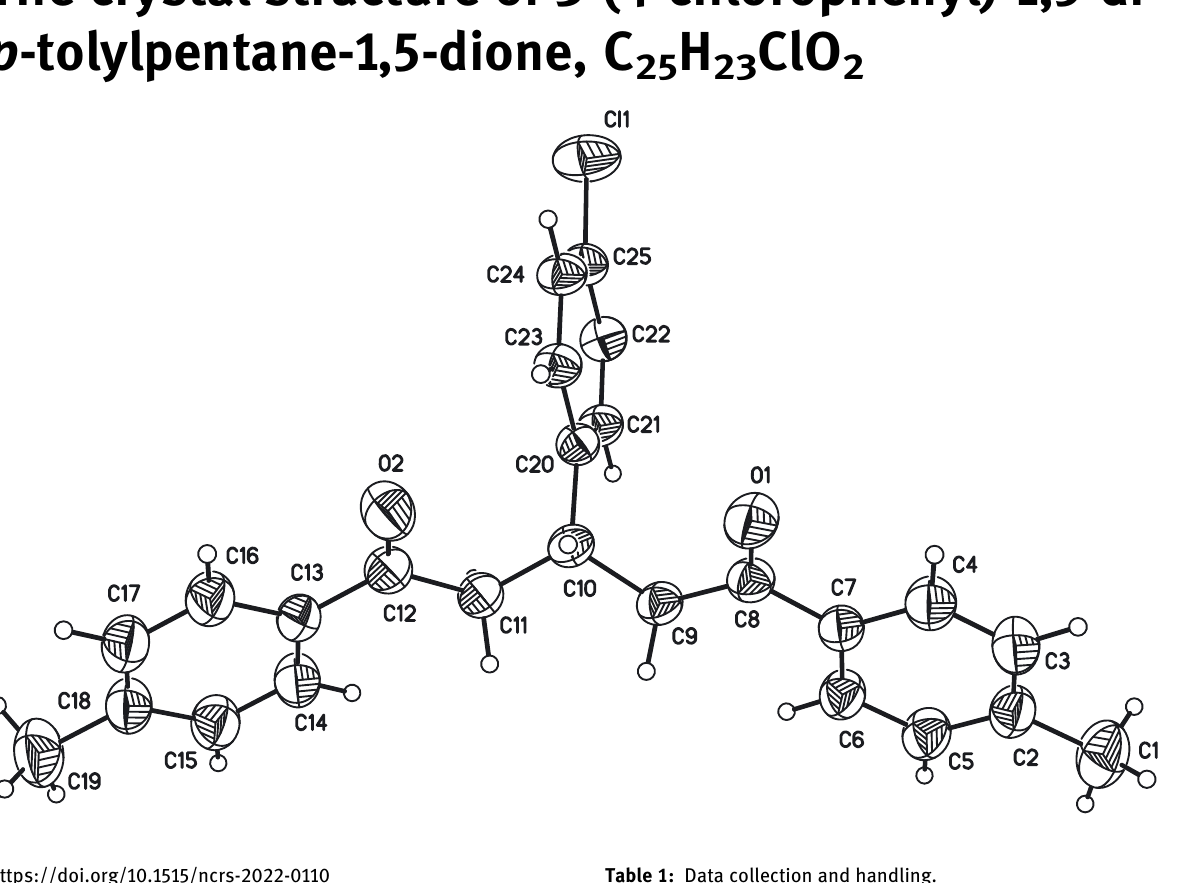
Table  : Data collection and